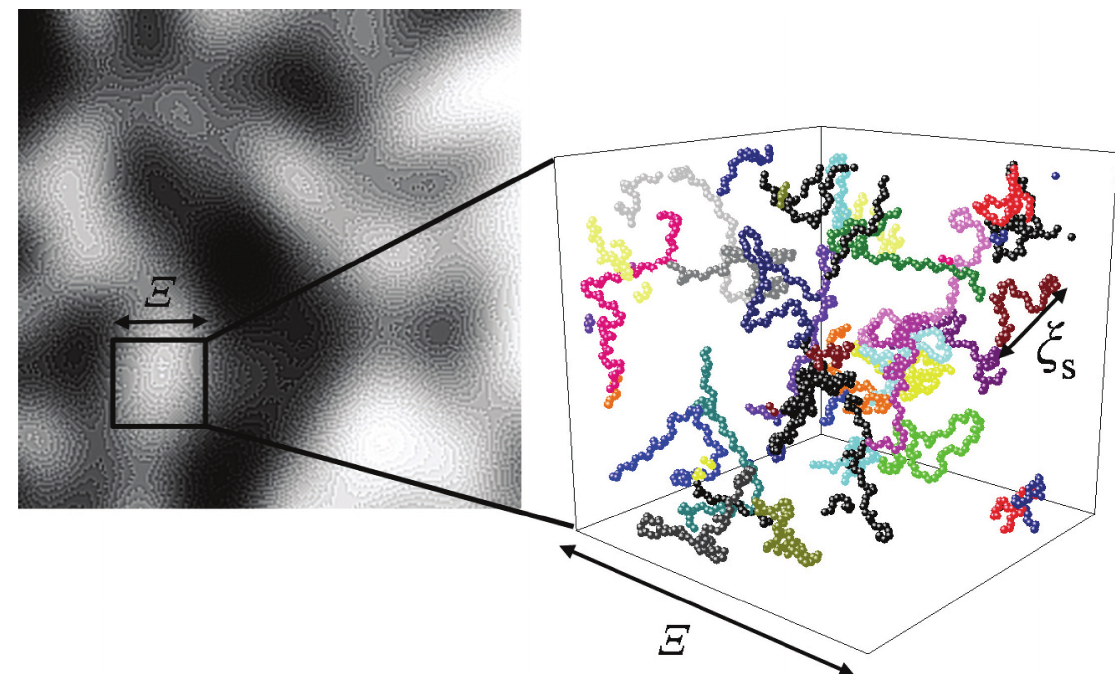
Figure 1: Scheme illustrating two correlation length parameters occurring in levan samples: Ξ describes the average size of the Debye inhomoge- neities, while ξ (= 2 R ) represents the size of the simulated polymer segment. Each segment is represented in different color. Ξ on the scheme cor- S g responds to 300 Å. The contours on the left-hand side scheme indicate the regions with the same local polymer density (i.e. volume fraction of the polymer). White color represents high density, black low